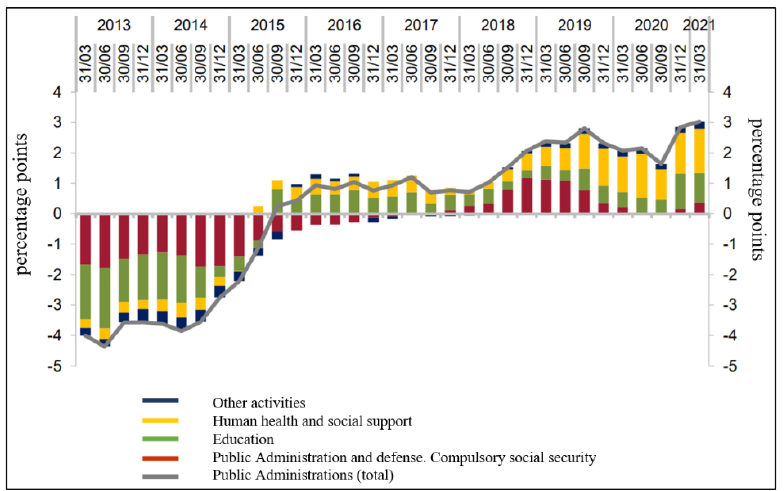
Figure 1. Variation of employment in general government by economic activity in Portugal. Source: DGAEP/DIOEP (position on 31 March 2021).